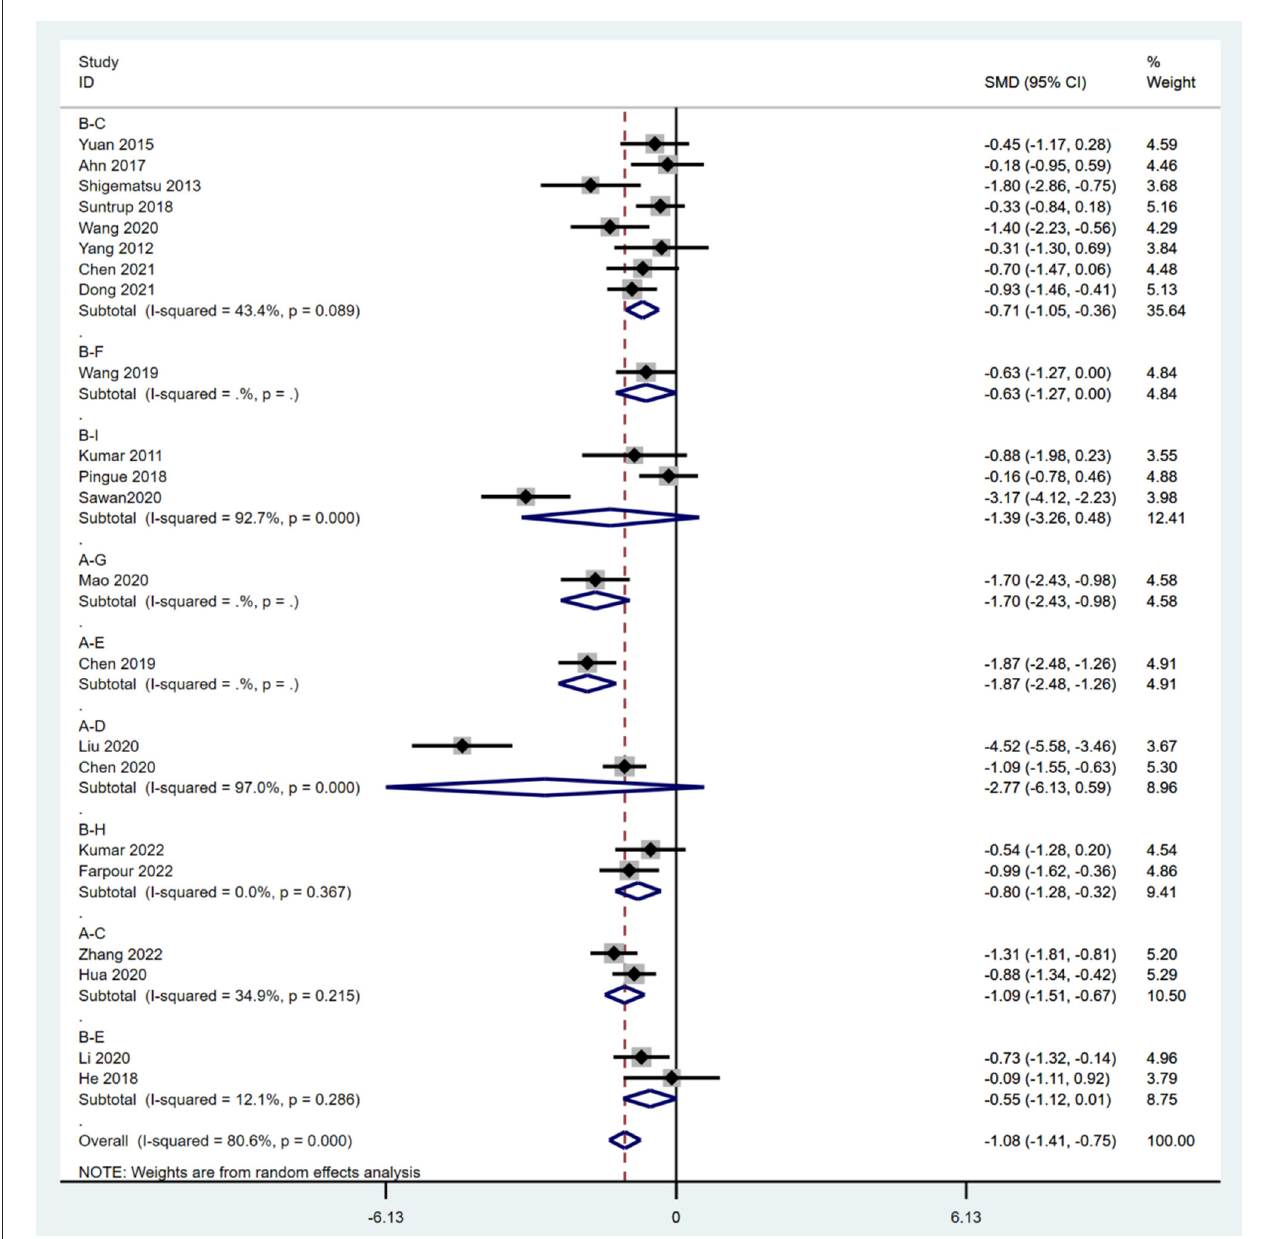
FIGURE3 Meta-analysis of pairwise comparisons. A, CT; B, sham; C, 20min + 1mA anodal; D, 20min + 1.2mA anodal; E, 20min + 1.4 mAanodal; F, 20min + 1.5mA anodal; G, 20min + 1.6mA anodal; H, 20min + 1.6mA anodal; I, 30min + 2mA anodal; SMD, standardized mean difference; CI, confidence interval.